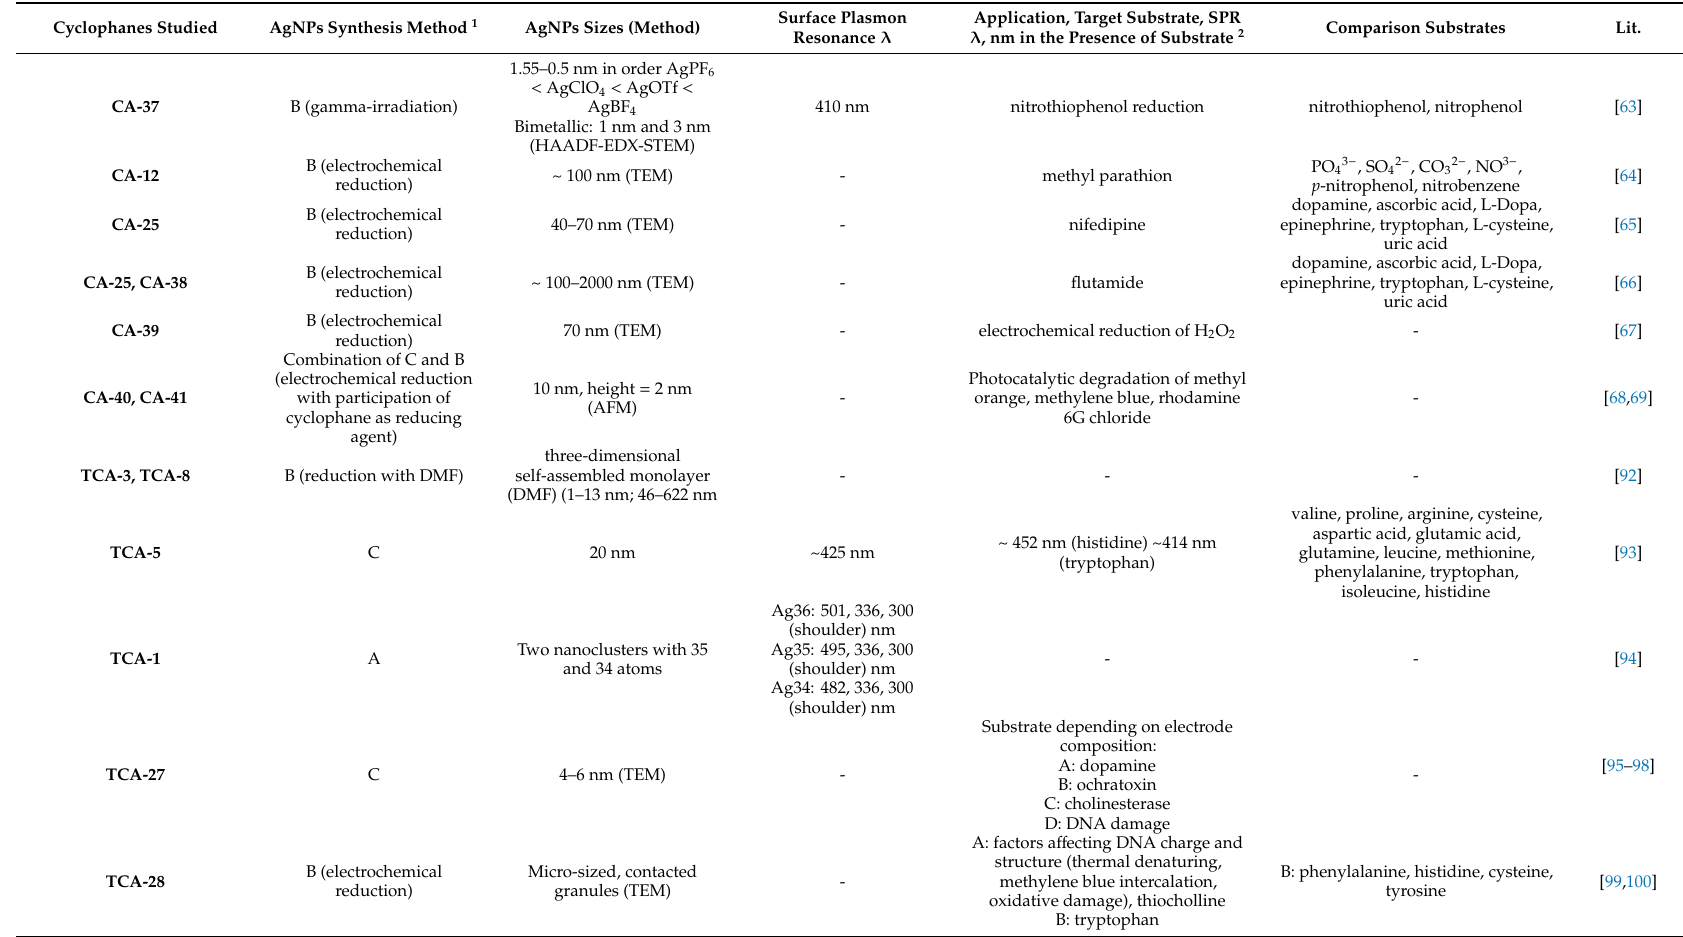
A: dopamine B: ochratoxin C: cholinesterase D: DNA damage A: factors a ff ecting DNA charge and structure (thermal denaturing, methylene blue intercalation, oxidative damage),